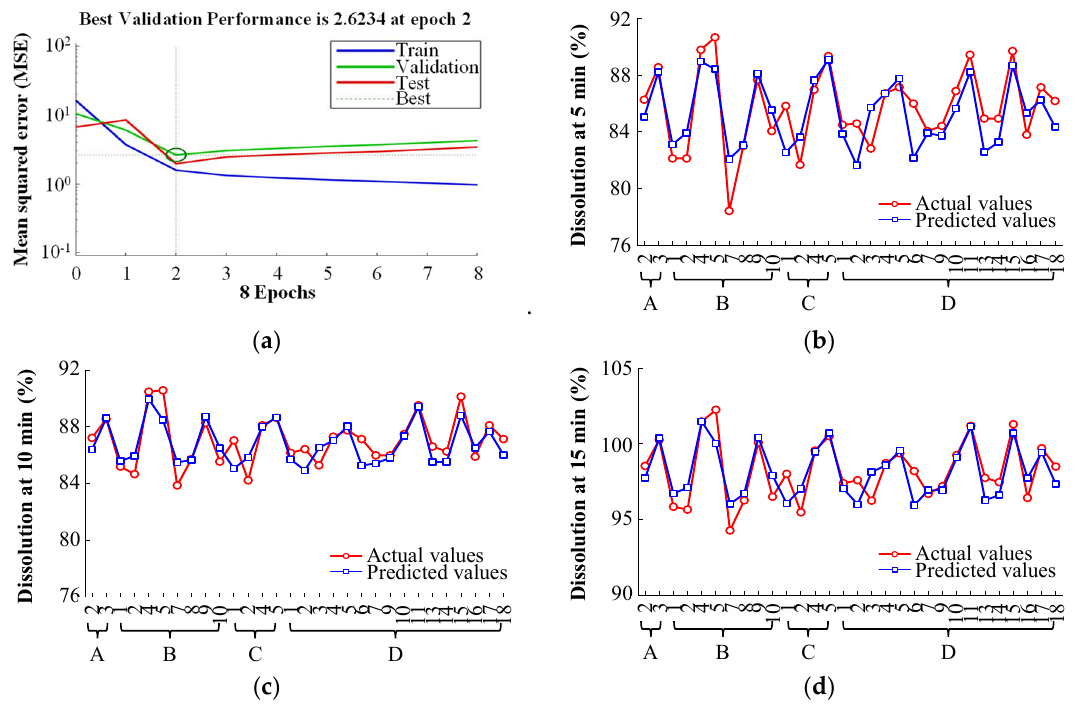
Figure 8. Training and fitting curve; ( a ) Performance of neural network during training; ( b ) Actual vs. Predicted dissolution at 5 min; ( c ) Actual vs. Predicted dissolution at 10 min; ( d ) Actual vs. Predicted dissolution at 15 min. For the reader’s clarity, the MCC abbreviations (X-axis) in ( b )–( d ) have been defined. The manufacturers of MCC are labeled using uppercase letters: A, DFE Pharma; B, FMC BioPolymer; C, Blanver; D, JRS Pharma GmbH & Co. KG. The details of the abbreviations are shown in Table 2.